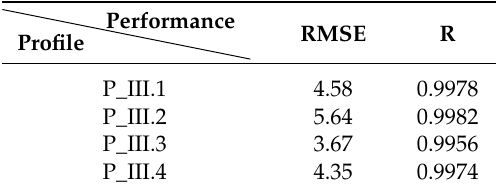
Table 5. Performance measures for each